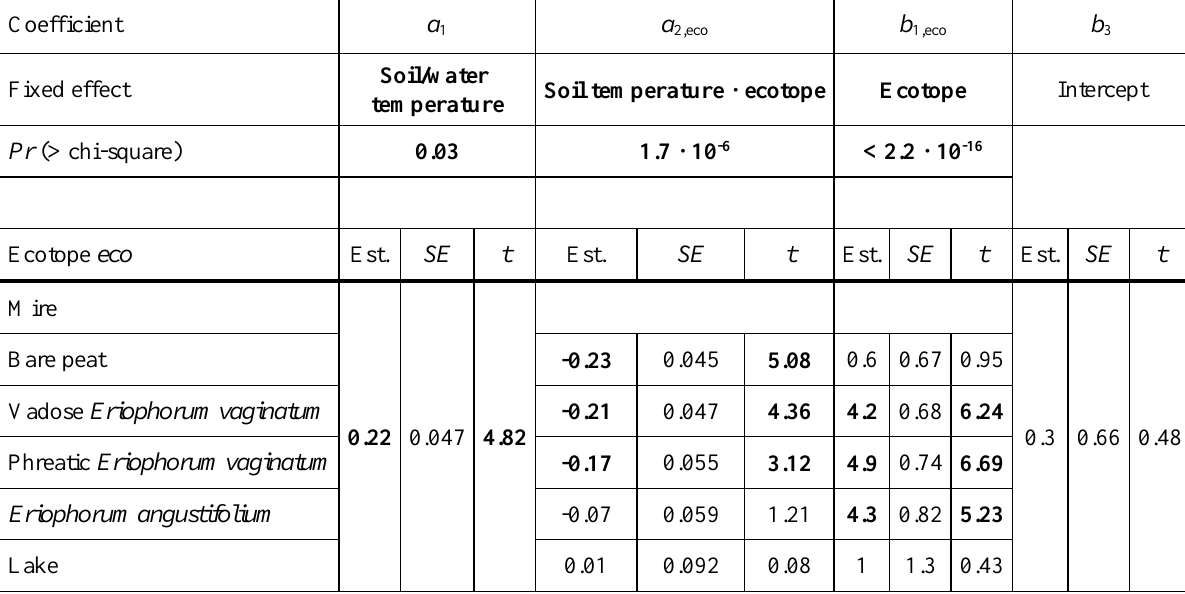
Table 6. Parameters of the linear mixed effects model for CH 4 flux to the atmosphere from the ecotopes. Significant fixed effects and coefficients in bold. Reference level for ecotope: mire. Est. = estimate; SE = standard error; t = t